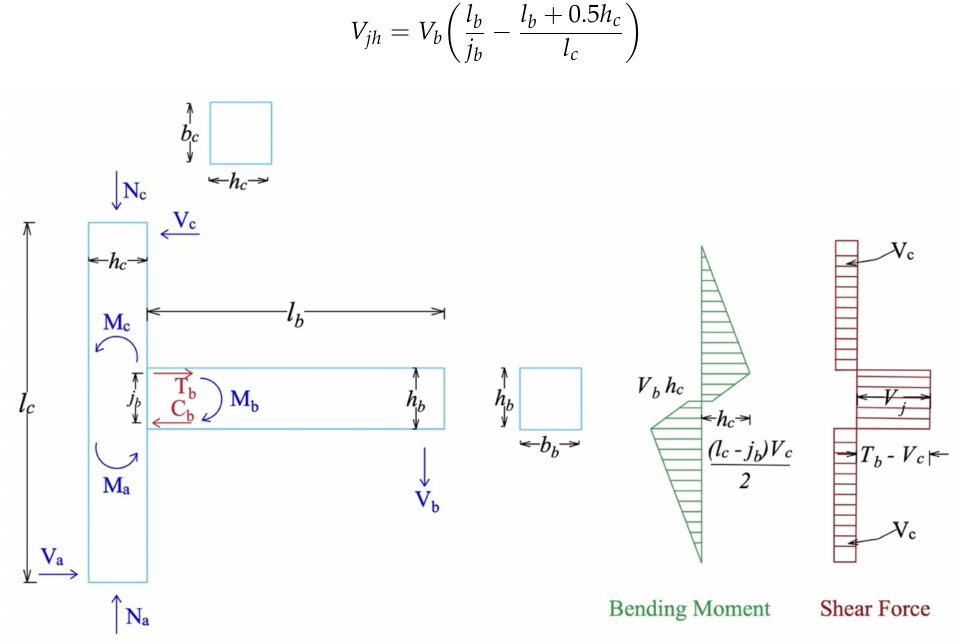
Figure 3. Internal forces and reactions in beam–column joints under lateral